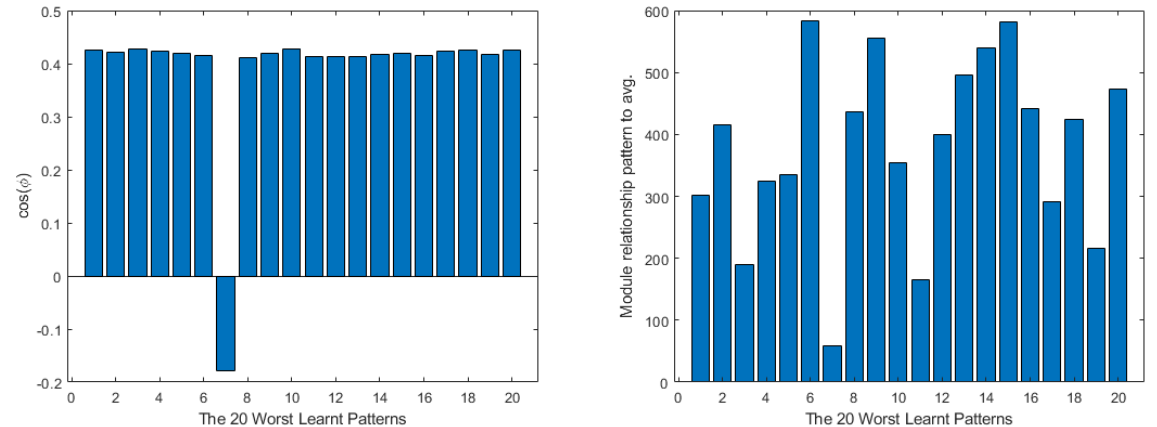
(cid:12) (cid:12) 𝜕𝐿𝑜𝑠𝑠 ∂ Loss (cid:12) (cid:12) | relationship to the average (cid:12) (cid:12) relationship to the average ∂ W n 𝜕𝑊 𝑛